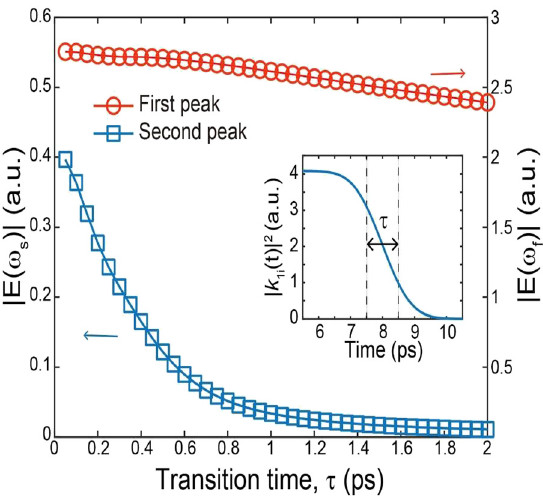
Figure 5: Role of the characteristic transition time in resonance- enhanced spectral funneling. Spectral amplitudes at the funda- mental (red color) and second-order (drawn with red color) reso- nance frequencies plotted as a function of the characteristic transition time. The inset shows the exemplary time-varying behavior of | k 1 i | 2 plotted by assumingthe characteristic timeof 1